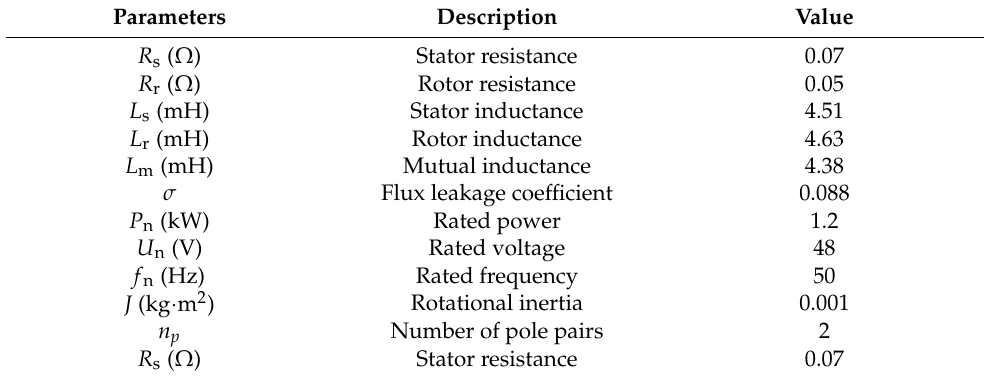
Table 2. The parameters of the